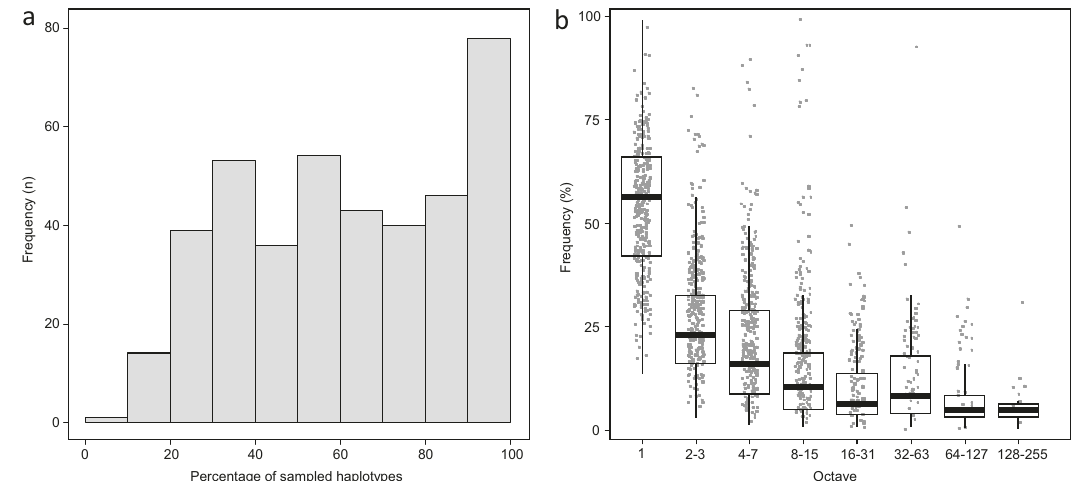
Fig. 2 Histogram of sampled genetic diversity in European butter fl ies. a Observed number of COI haplotypes/asymptote for 404 species of European butter fl ies represented by at least six COI sequences; 62% of the estimated haplotype diversity is encompassed by the dataset. b Frequency of COI haplotypes belonging to the eight log 2 classes of abundance for the same 404 species. Most haplotypes were found in single specimens. Boxplots represent median values among species and 25% interquartile ranges.